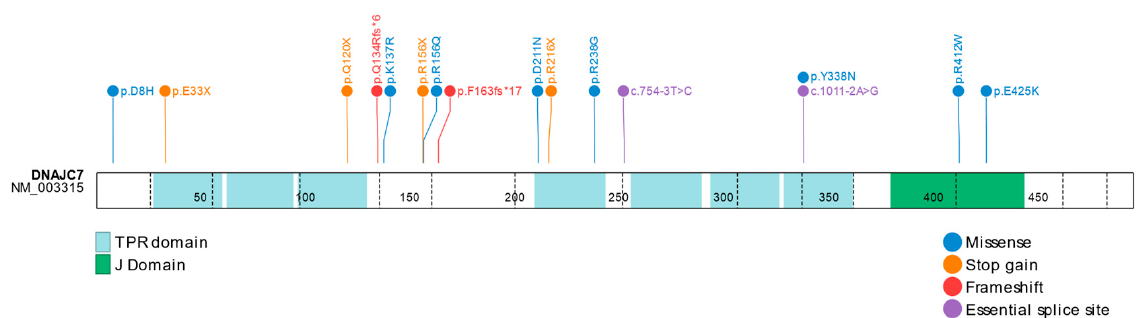
Figure 1. Protein schematic of the previously reported likely damaging variants in DNAJC7 in various ALS cohorts. Variants were previously reported to be associated with ALS by Farhan et al.; Jih et al.; Wang et al.; He et al.; Sun et al. [3,26–29]. Exon boundaries are indicated by black vertical, dashed lines.